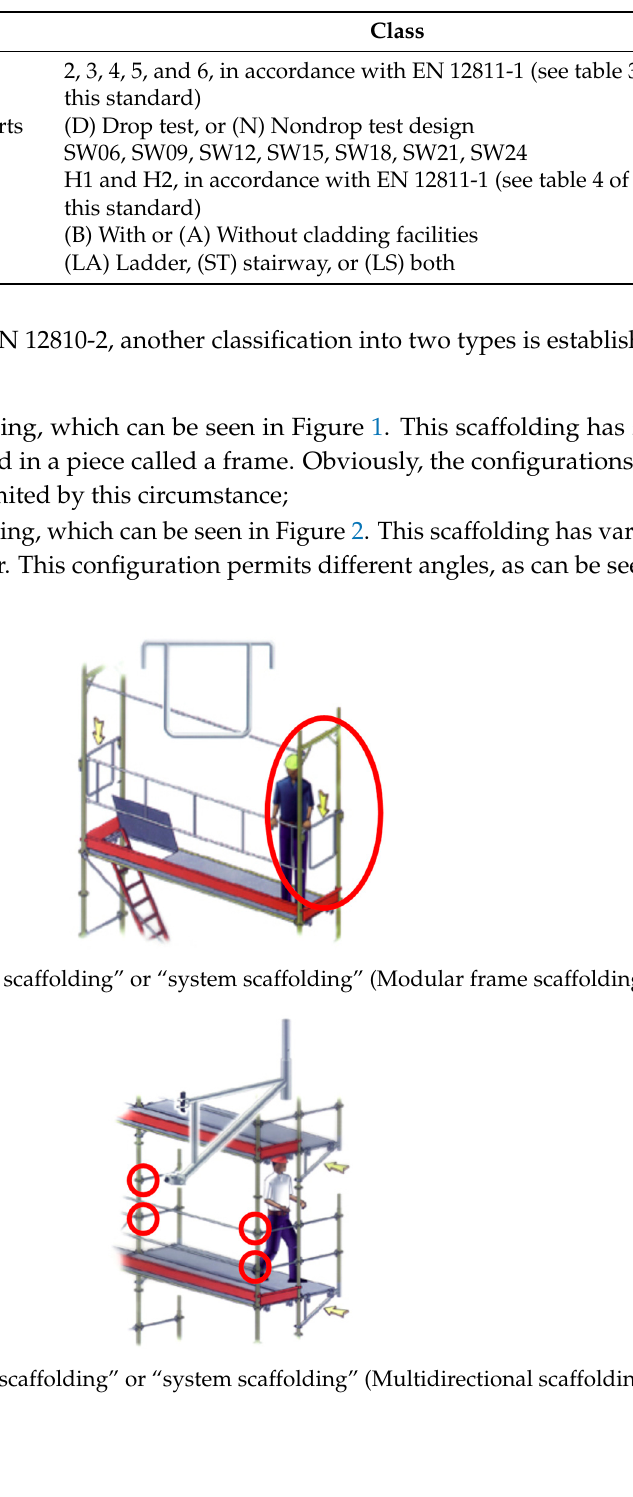
Table 2. Different classes of scaffolding according to different criteria set by standard EN 12810-1.